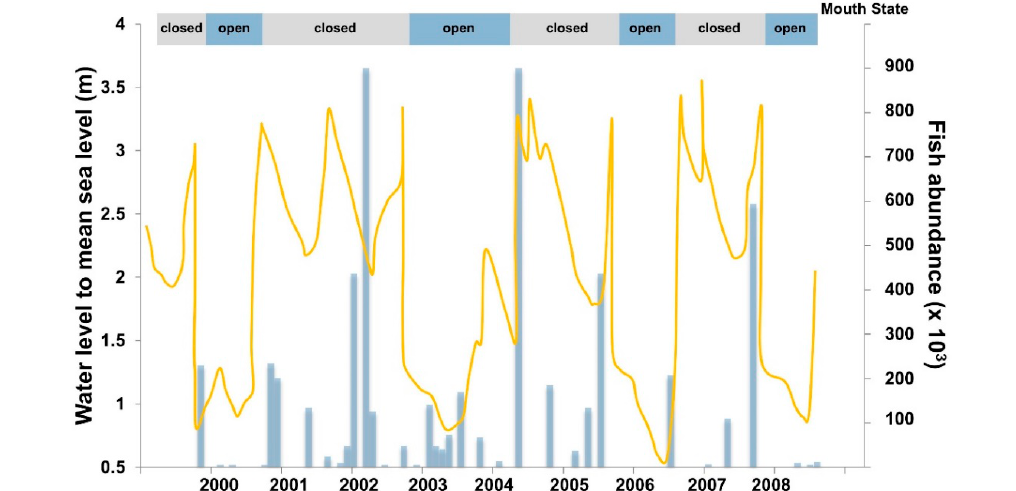
Figure 11. Graphic illustration of the long-term data for water levels (yellow line), fish abundance (blue bars), and mouth state used to identify trends and patterns on which high-confidence EFlow assessments were based (modified from [55]).